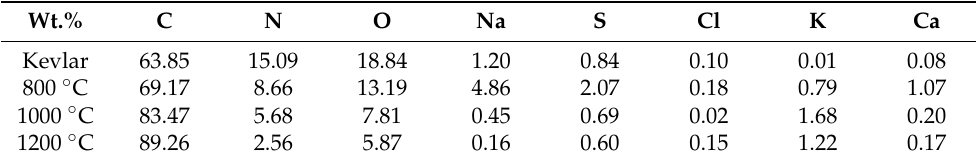
Table 3. Effect of carbonization temperature on elemental composition of activated carbon fabric.